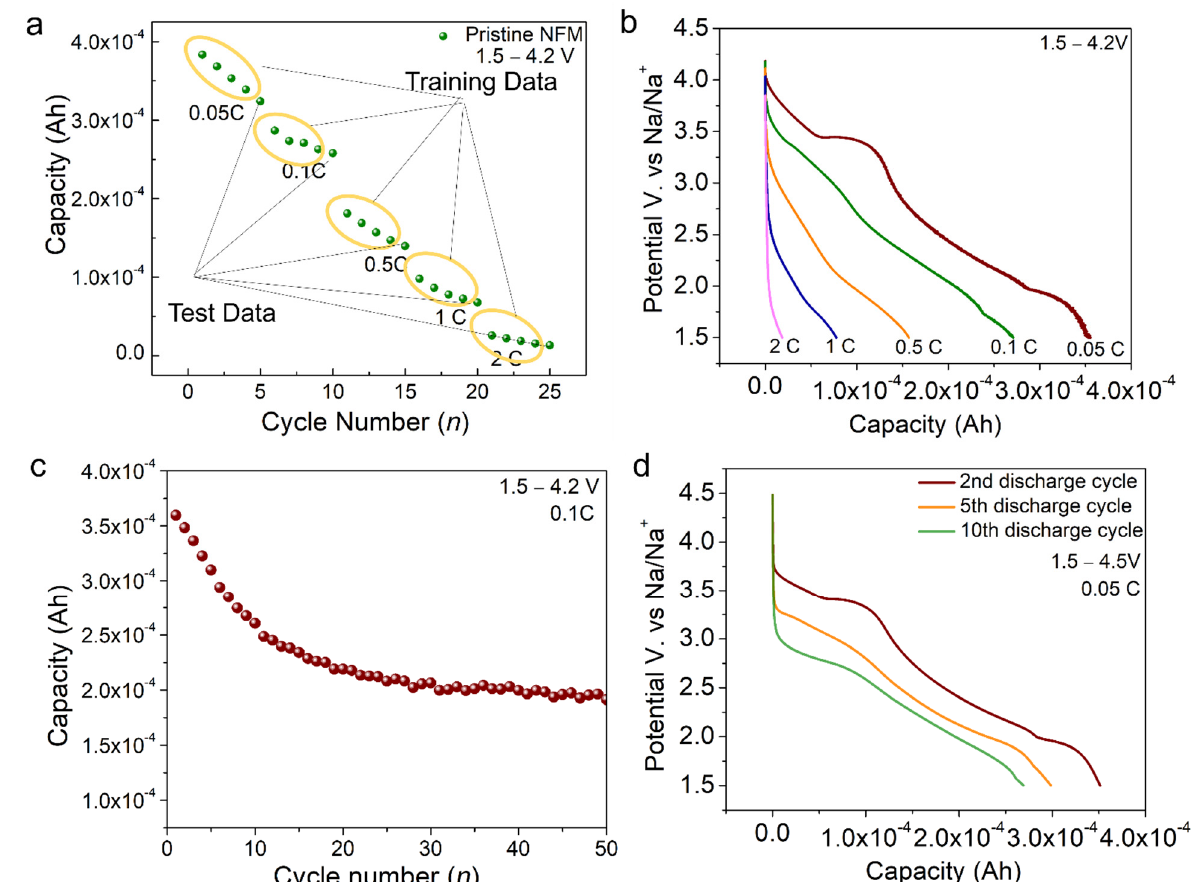
Figure 4. ( a ) Rate capability at different current rates from 0.05 C–4 C for NFM cathodes. ( b ) Gal- vanostatic discharge curve for NFM cycled between 1.5–4.2 V vs. Na/Na + for the fifth cycle of each current rate from 0.05 C to 2 C rate. ( c ) Specific capacity as a function of cycle number for NFM cathode cycled between 1.5–4.2 V vs. Na/Na + at 0.1 C rate for 50 cycles. ( d ) Galvanostatic discharge curve for NFM cycled between 1.5–4.5 V vs. Na/Na + for the 2nd, 5th, and 10th cycles at 0.05 C rate (1 C = 260 mA/g).